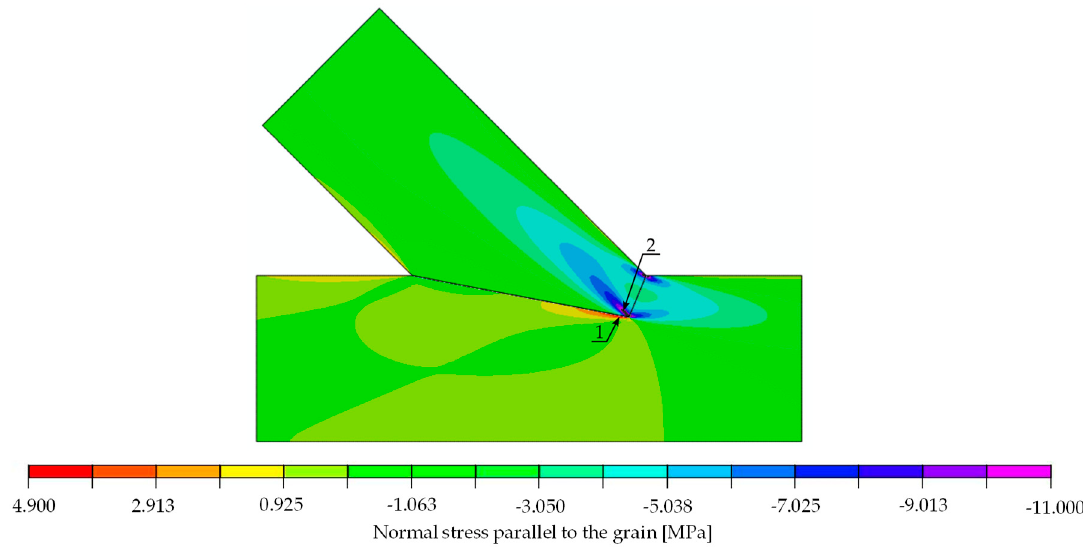
Figure 14. Normal stress parallel to the grain [MPa]. Force 29.6 kN.